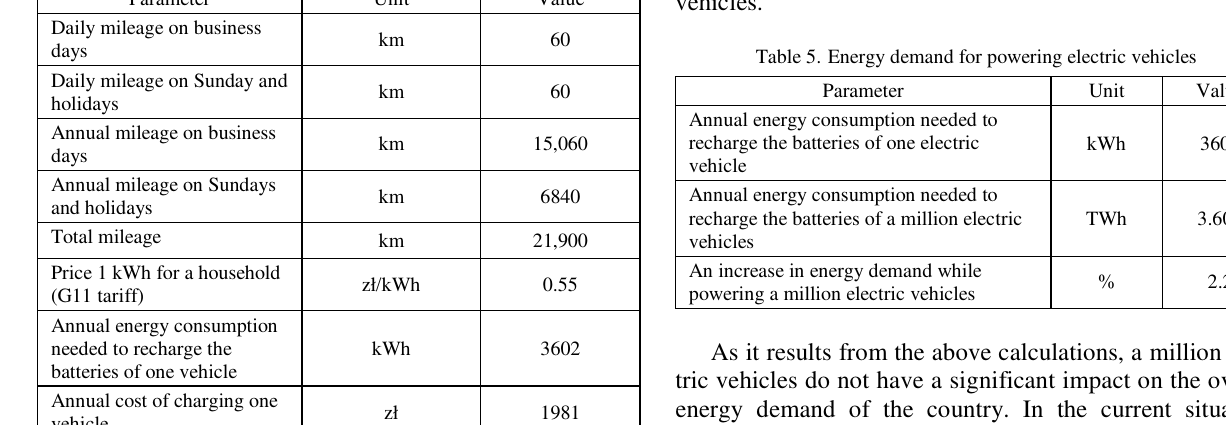
Table 4. Annual energy consumption needed to recharge the batteries of one vehicle and determine the related costs Parameter